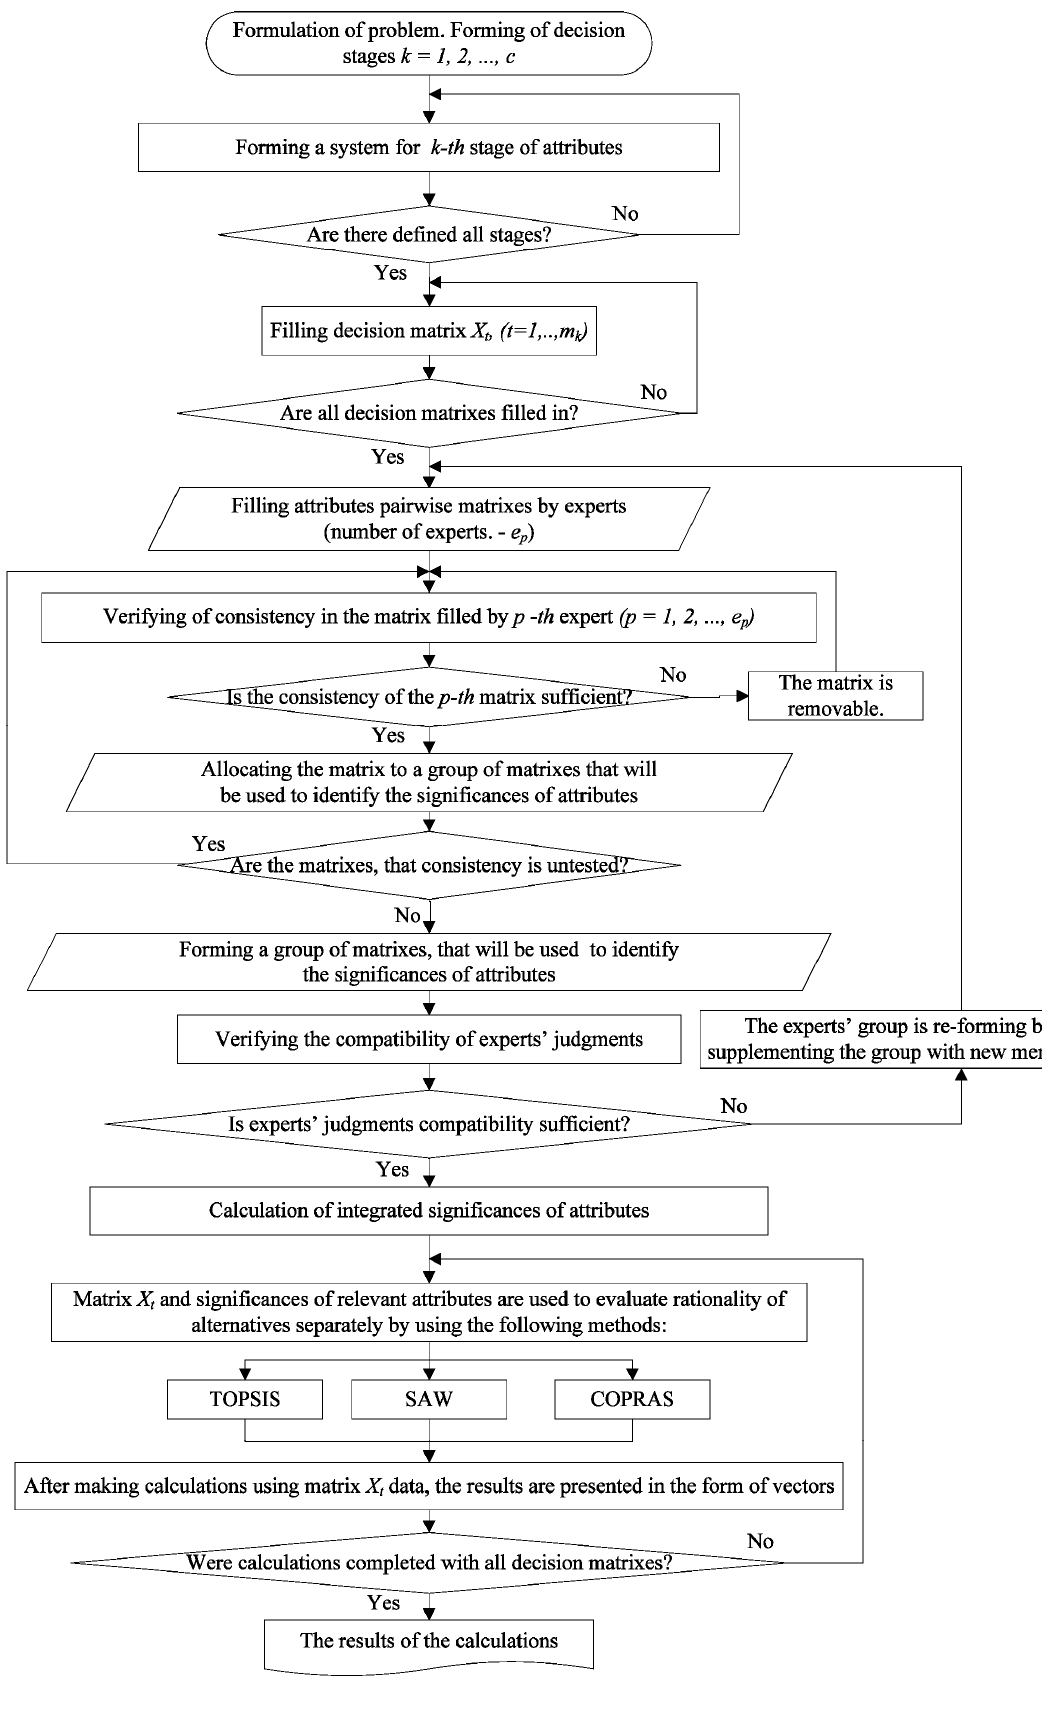
Fig. 1. Part 1 of the algorithm of the multi-stage decision synthesis method